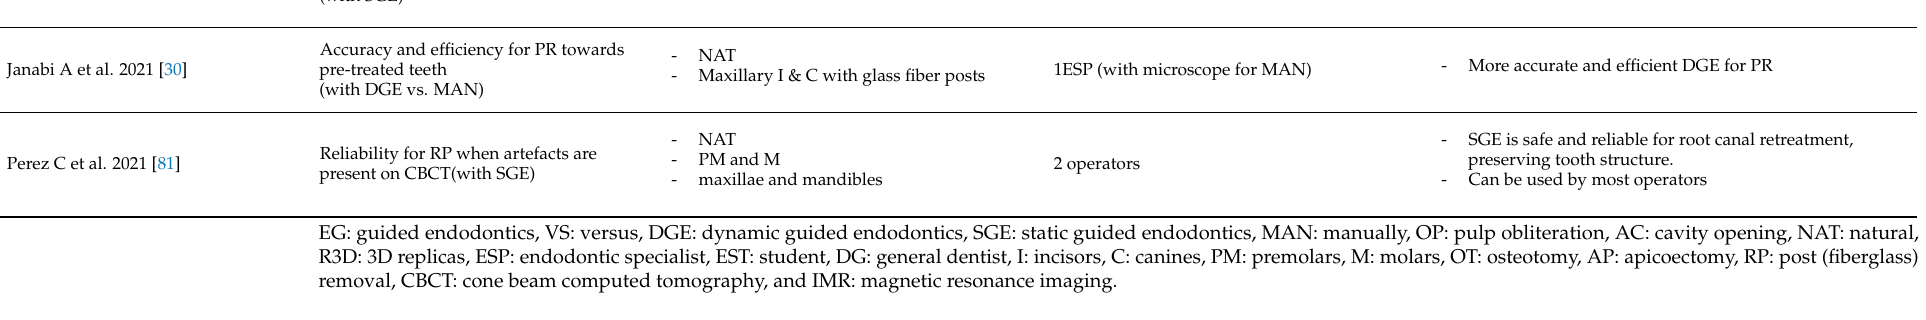
Table 2. Other types of articles included in the